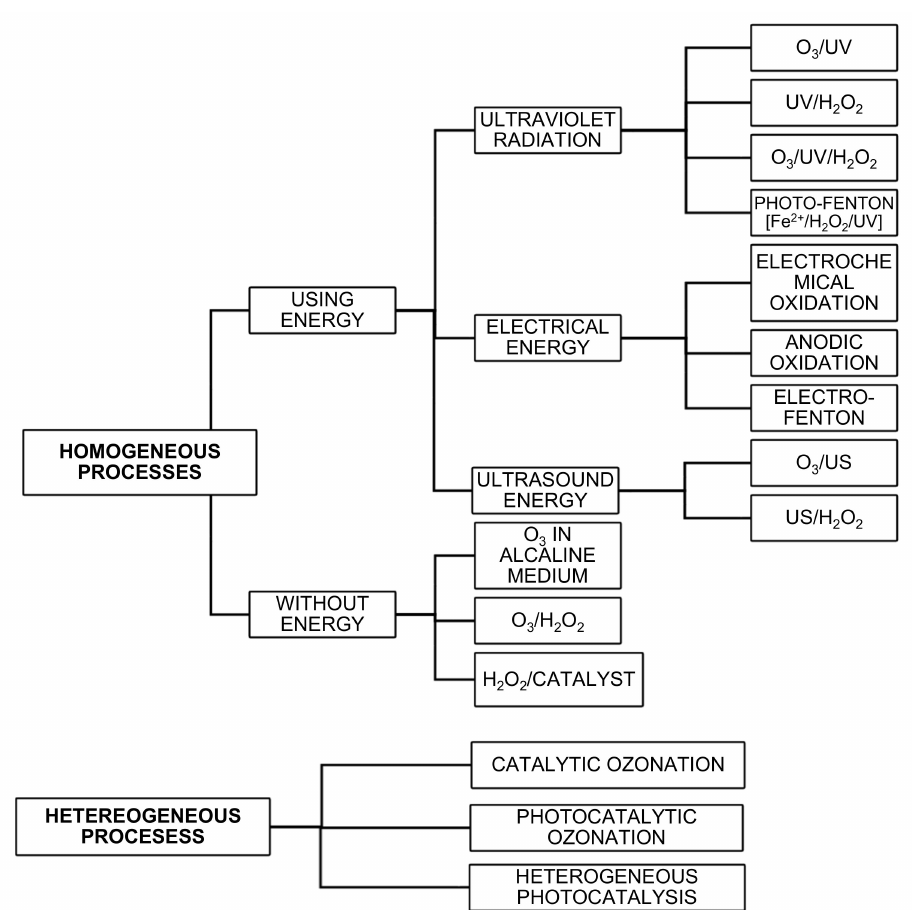
Figure 1. Classification of advanced oxidation processes. Abbreviations used: O 3 , ozonation; H 2 O 2 , hydrogen peroxide; UV, ultraviolet radiation; US, ultrasound energy; Fe 2+ , ferrous ion, modified of